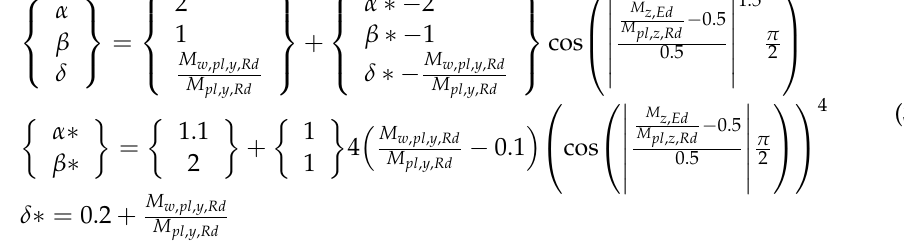
Table 1. Improved interaction formulae with changed parameters α , β , and δ (variant No. 4). M y , Ed < δ δ ≤ M y , Ed 0 ≤ M pl , y , Rd BEd Bpl , Rd ≤ 1 − Mz , Ed Mpl , z , Rd